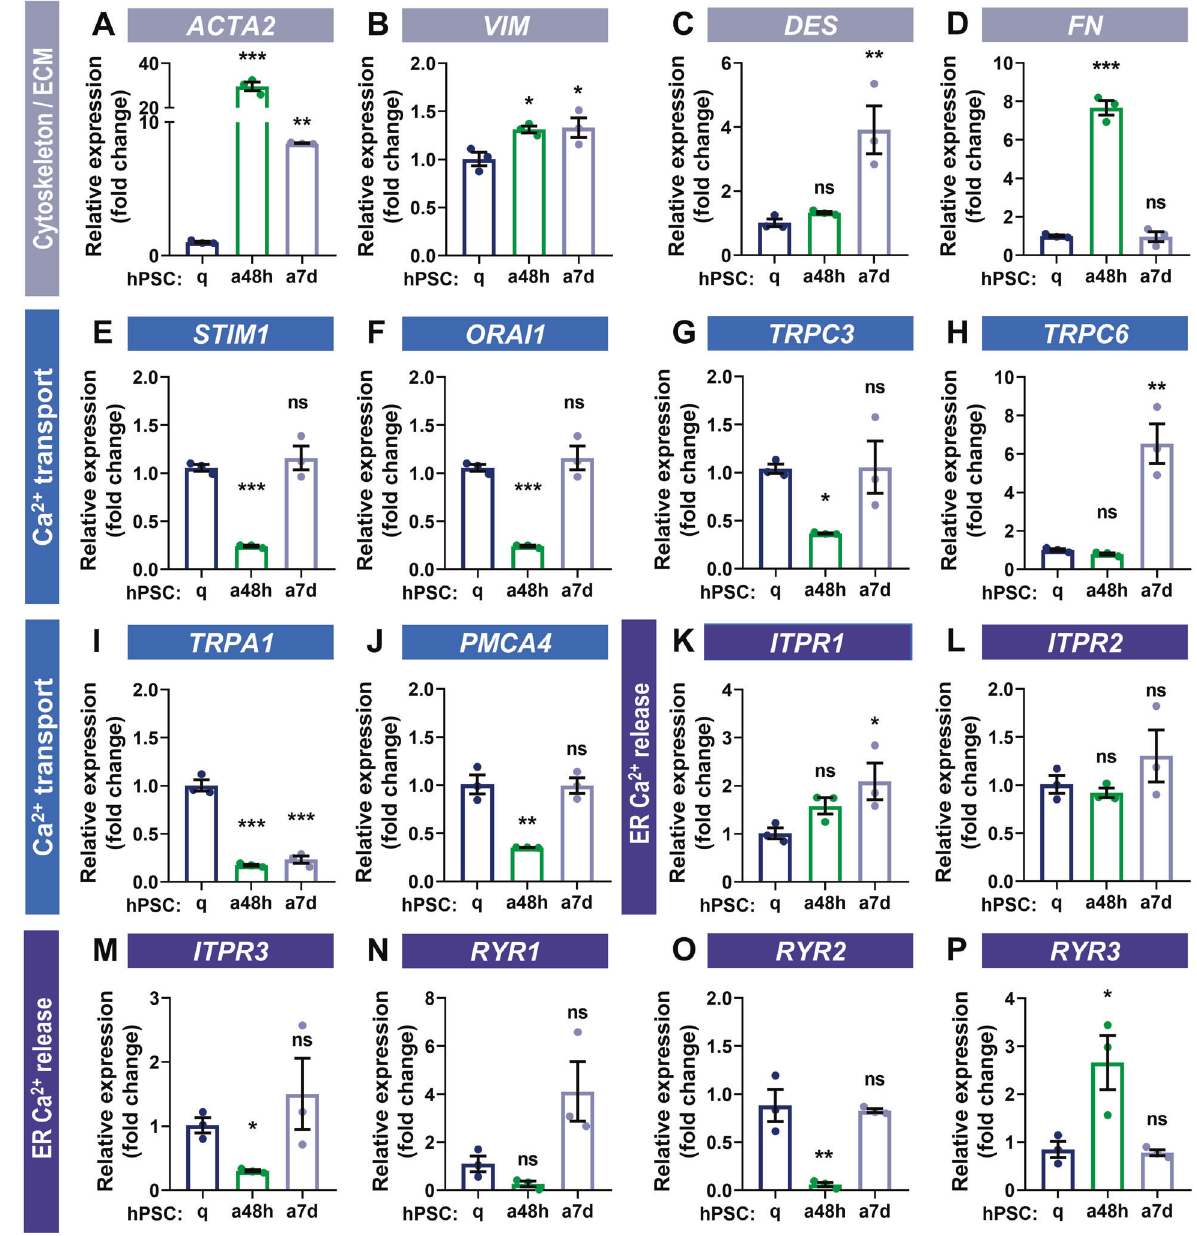
Fig. 4 Expression of selected genes in quiescent and TGF- β -activated human PSCs. Relative mRNA levels (qPCRs) of selected targets (±SEM) in quiescent hPSC (blue) hPSCs activated with TGF- β (5 ng/ml) for 48 h (green) and for 7 days (grey): A actin alpha 2, smooth muscle ( ACTA2 ); B vimentin ( VIM ); C desmin ( DES ); D fi bronectin ( FN ); E stromal interaction molecule 1 ( STIM1 ); F calcium release-activated calcium channel protein 1 ( ORAI1 ); G transient receptor potential cation channel, subfamily C, member 3 ( TRPC3 ); H transient receptor potential cation channel, subfamily C, member 6 ( TRPC6 ); I transient receptor potential ankyrin 1 channel ( TRPA1 ); J plasma membrane calcium ATPase, isoform 4 ( PMCA4 ); K inositol 1,4,5- trisphosphate receptor type 1 ( ITPR1 ); L inositol 1,4,5-trisphosphate receptor type 2 ( ITPR2 ); M inositol 1,4,5-trisphosphate receptor type 3 ( ITPR3 ); N ryanodine receptor type 1 ( RYR1 ); O ryanodine receptor type 2 ( RYR2 ); P ryanodine receptor type 3 ( RYR3 ). Expression was normalised to glyceraldehyde-3-phosphate dehydrogenase ( GAPDH) ( n = 2, N = 3). Statistical signi fi cance was calculated using the one-way ANOVA test followed by a post hoc analysis with the Dunnett test. ns non-signi fi cant difference, * p < 0.05, ** p < 0.01; *** p < 0.001. inducing cell death. Alcoholic pancreatitis results in the role in the regulation of cell death induced by toxic stimuli in a activation of PSCs throughout the pancreatic tissue. Activated large spectrum of tissue (myo) fi broblasts. PSCs become resistant to alcohol metabolites owing to their enhanced Ca 2 + handling capacity compared to the quiescent cells: activated PSCs are protected against excessive [Ca 2 + ] i overload by downregulation of TRPA1. Signi fi cant resistance of PACs. Alcohol metabolites also act on quiescent PSCs inducing activated PSCs to noxious stimuli (such as alcohol metabolites) [Ca 2 + ] i overload, disrupting the mitochondrial potential, and might explain why pancreatic fi brosis is a frequent complication